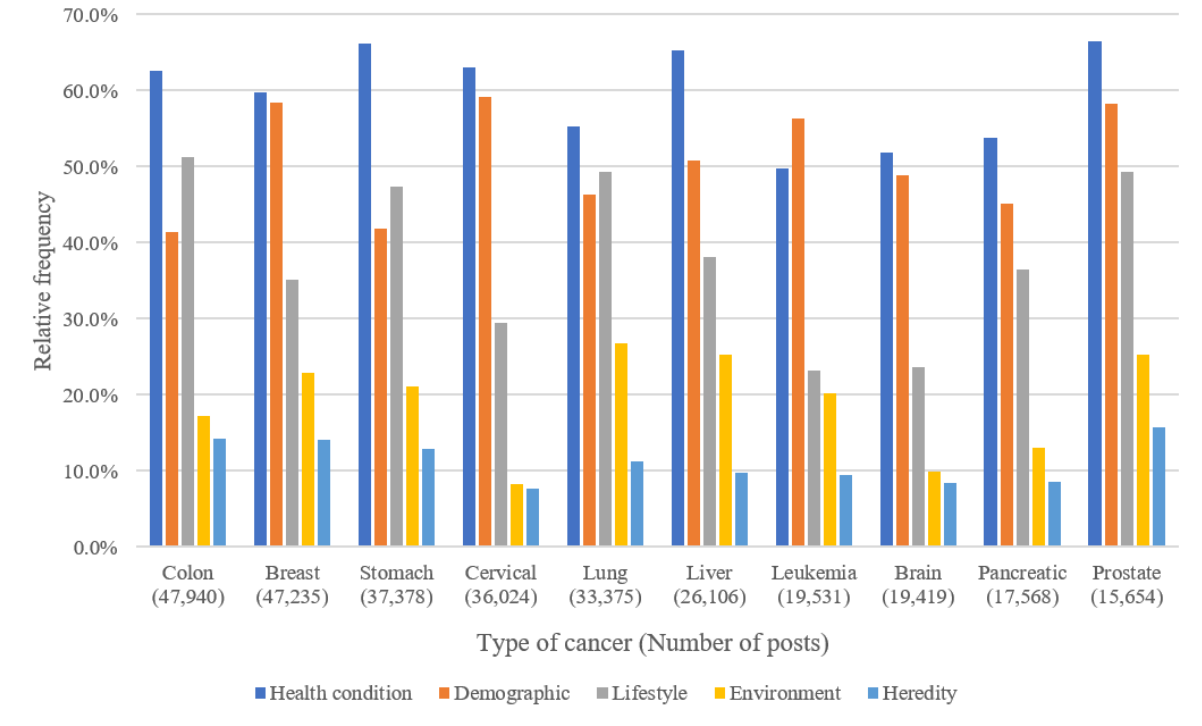
Figure 3. Relative frequencies of the risk factor superclass by top 10 cancer types in social media